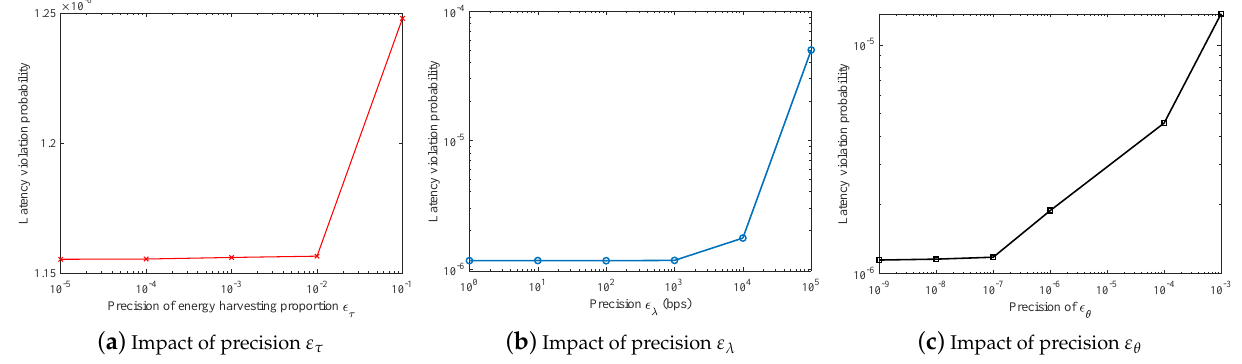
Figure 4. Impact of precision parameters on the numerical results.